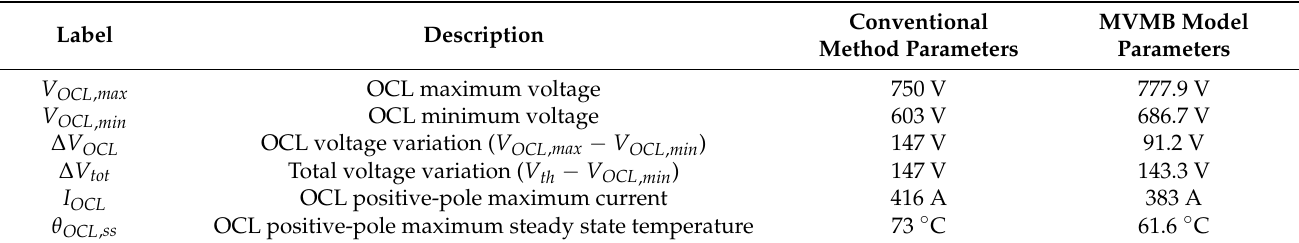
Table 6. Results and techniques comparison for FS 2.